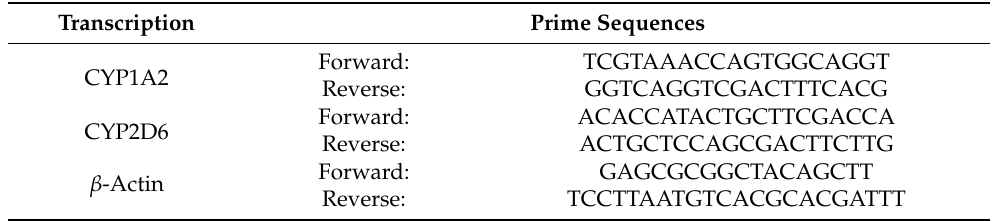
Table 1. PCR data were analyzed using the comparative CT method. Samples of iPSC-HLCs cultured in scaffolds and in dishes were analyzed as biological replicates ( n = 3). Each sample was subjected to three technical replicates of each PCR reaction. β -Actin was used as the internal control. Table 1. Primers used for real-time